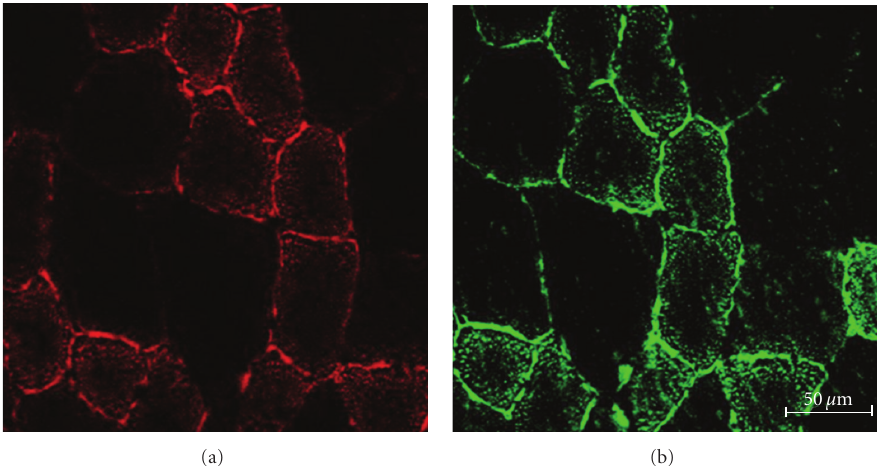
Figure 2: Comparison of serial cross sections from rat tibialis anterior (TA) muscle demonstrates that ORO and BODIPY staining are the strongest in the same fibers. (a) Fibers stained with ORO (red) demonstrate the appearance of spherical LDs within the muscle fibers. (b) Fibers stained with BODIPY (green) demonstrate the appearance of spherical LDs within the muscle